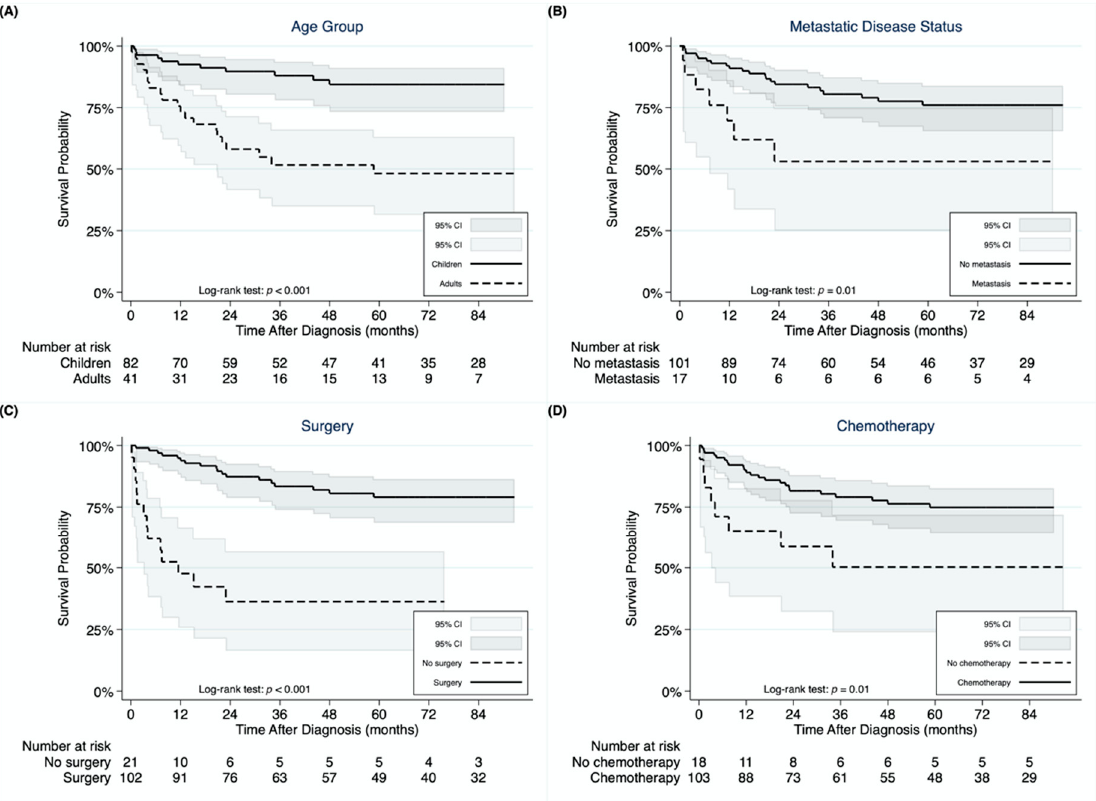
Figure 2. Kaplan − Meier curves demonstrating differences in overall survival for undifferentiated embryonal sarcoma of the liver between children and adults ( A ), between patients with and without metastasis at diagnosis ( B ), between patients undergoing surgery or not ( C ), and between patients receiving chemotherapy or not ( D ). Table 2. Risk factors associated with mortality in the entire